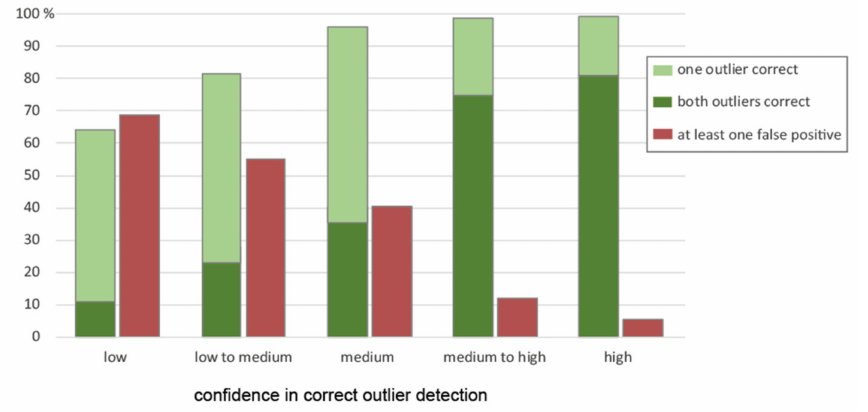
Figure 12. Hit rates and false alarms for different levels of confidence in correct outlier detection.